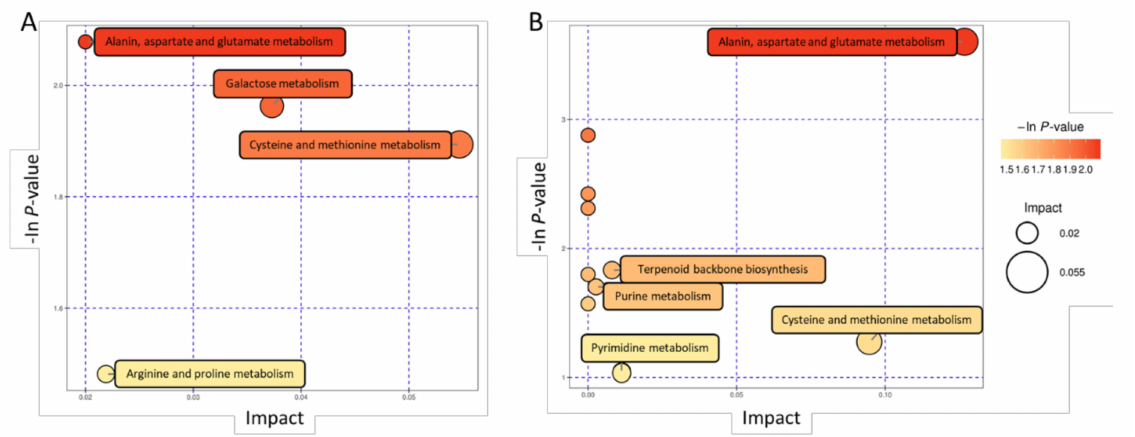
Figure 5. Metabolic pathway analysis of changed metabolites identified in boar seminal plasma. ( A , B ) was analyzed in positive and negative ions modes,